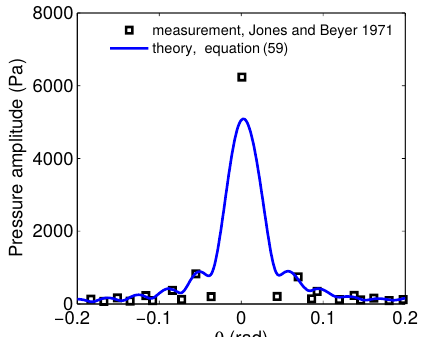
Figure 2. Comparison between Jones and Beyer’s experiment [1,35] and exact theory obtained computationally for the sum frequency second order pressure. Good quantitative agreement is found between measurement and theory with 0.98 correlation across scattered angle and overall mean square difference of less than 0.3